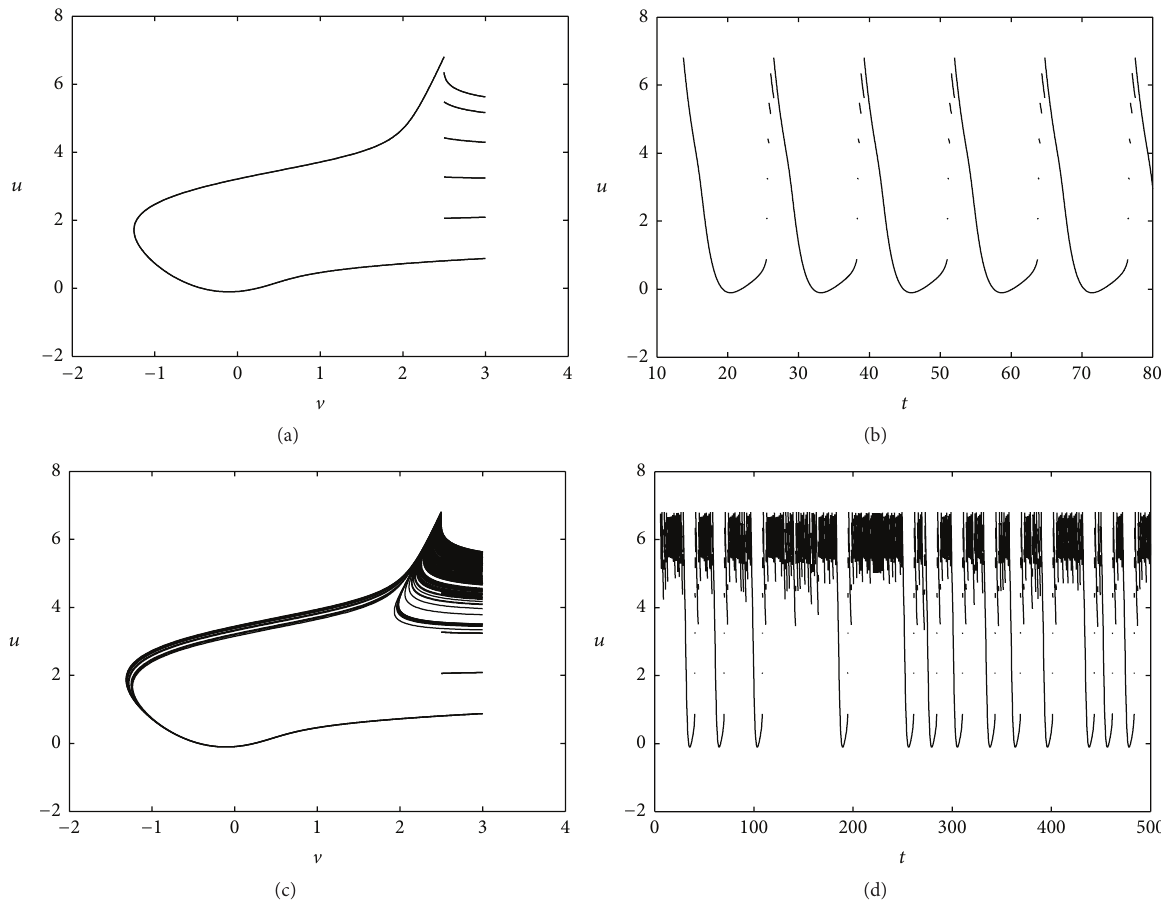
Figure 6: Attractor crisis of system (2) with parameters 𝐼 hom = 0.1485 , 𝑎 = 0.5 , 𝑏 = 1 , 𝑐 = 2.5 , and V 𝑝 = 3 . (a-b) Phase space projection and time series of an order 6 periodic solution for 𝑑 = 1.183 ; (c-d) phase space projection and time series of a chaotic attractor for 𝑑 = 1.182